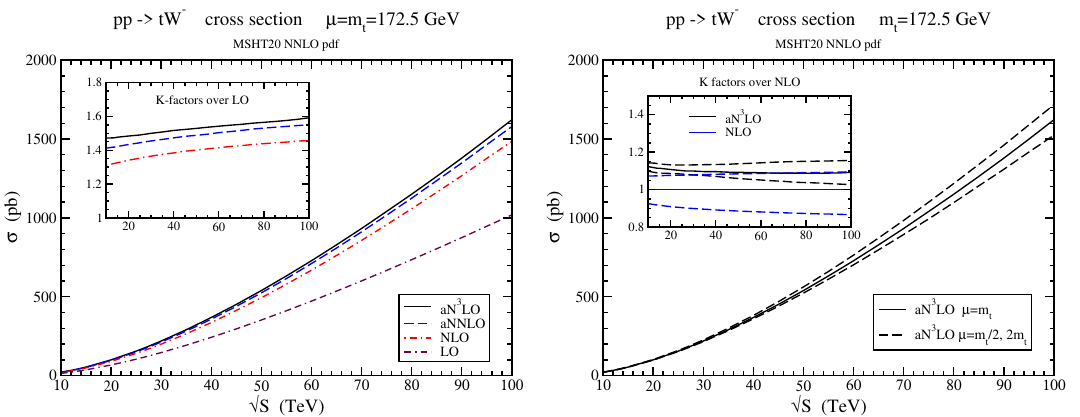
Figure 2: Cross sections for tW production at collider energies.